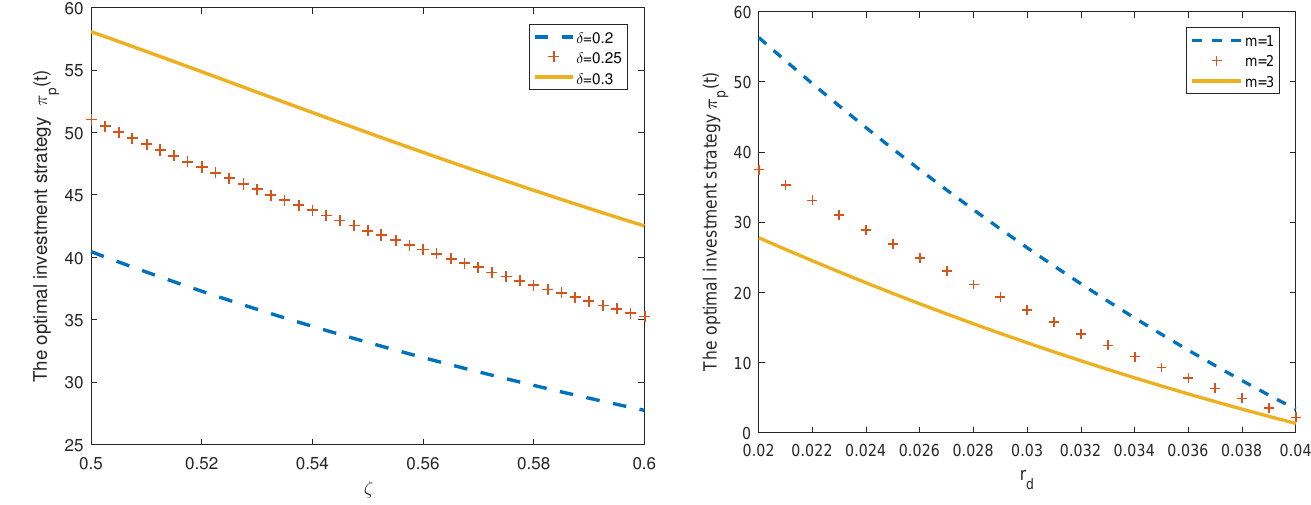
Figure 5. The impact of parameters δ , ζ , r d and m on π p ( t )